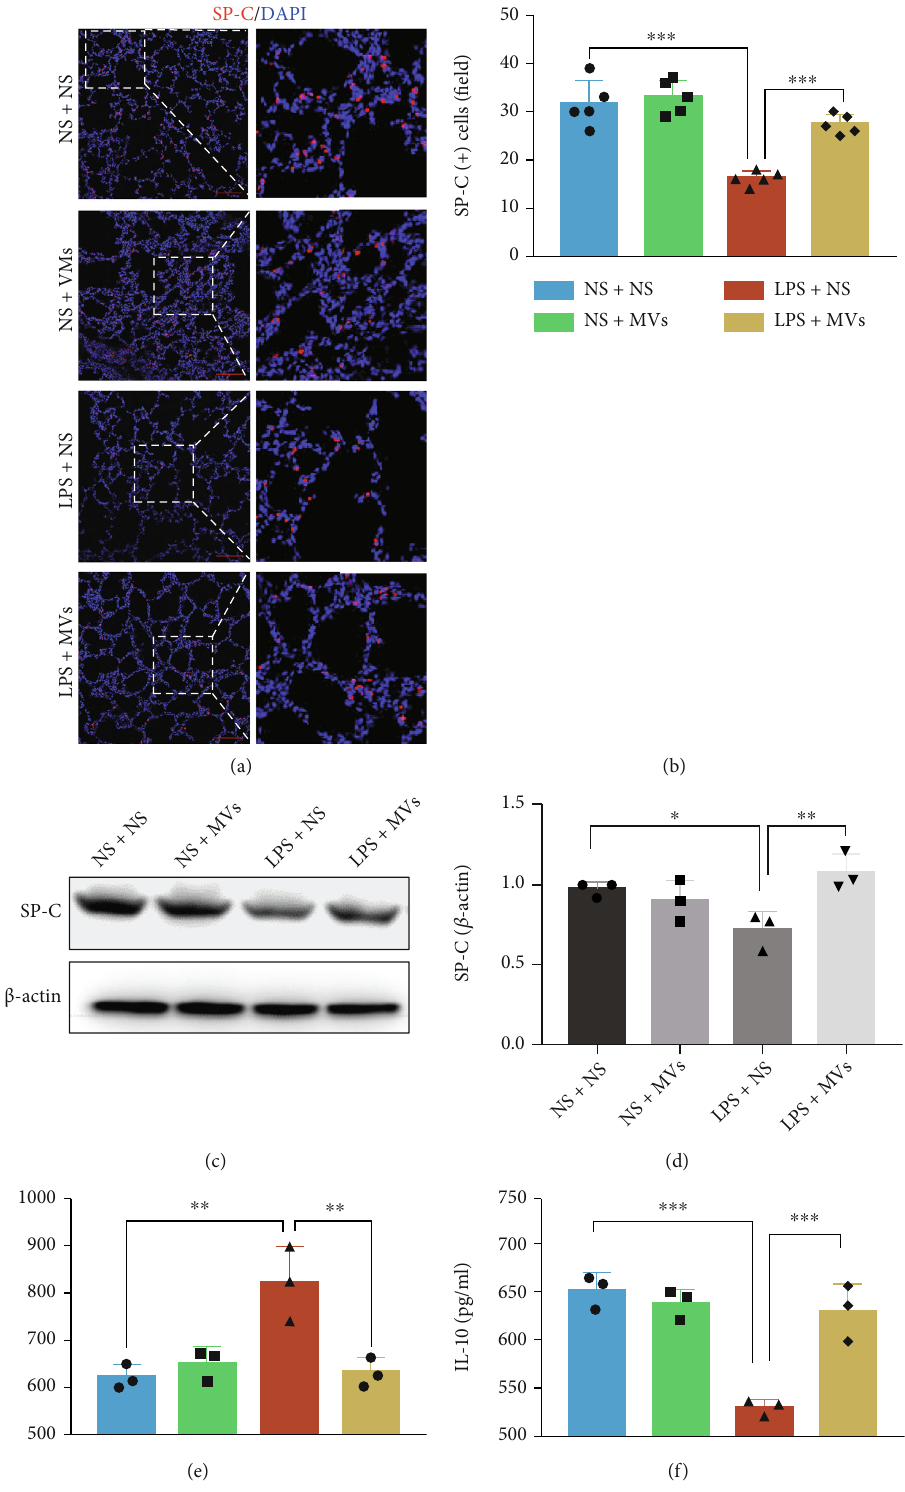
Figure 7: E ff ect of MVs on AT2 cells and macrophage-related in fl ammatory factors in vivo . (a) Representative immuno fl uorescence images of SP-C (red) staining in lung, scale bar = 100 μ m. (b) Quanti fi cation of SP-C-positive cells in each group ( N = 5 , ANOVA, ∗∗∗ P < 0 : 001 ). (c) Western blot detection of protein levels of SP-C in each group. (d) Densitometric analysis was used to quantify the protein levels of SP-C ( N = 3 , ANOVA, ∗∗∗ P < 0 : 001 ). The levels of (e) IL-6 and (f) IL-10 in lung homogenate were measured with ELISA ( N = 3 , ANOVA, ∗∗ P < 0 : 01 and ∗∗∗ P < 0 : 001